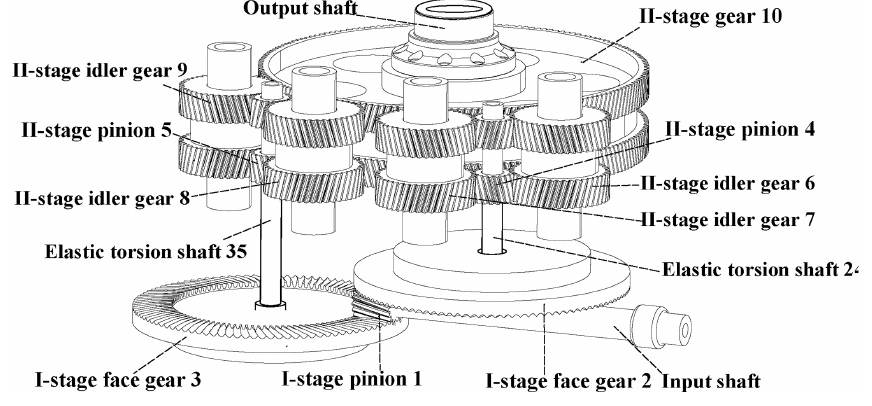
Figure 1. Schematic diagram of the FGDPSTS.